Question: State the chart type depicted above.
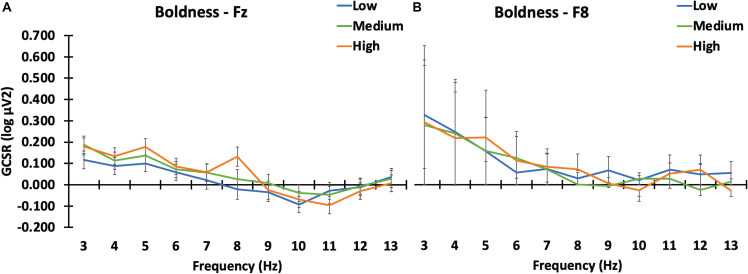
Answer: bar